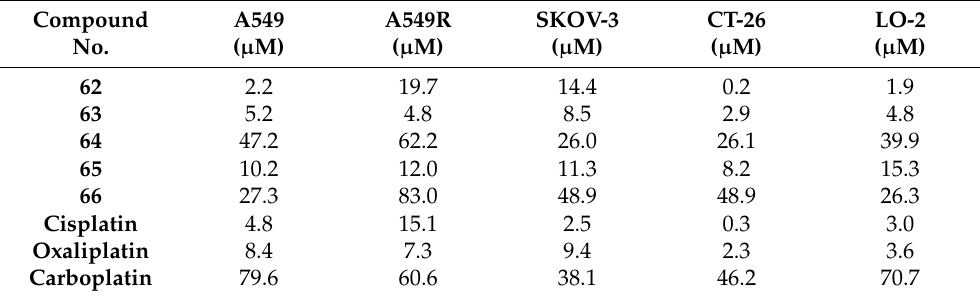
Figure 65. Structure of naproxen platinum (IV) hybrid derivatives. Table 52. In vitro cytotoxic activities of naproxen platinum (IV) hybrid compounds ( 62 – 66 ).